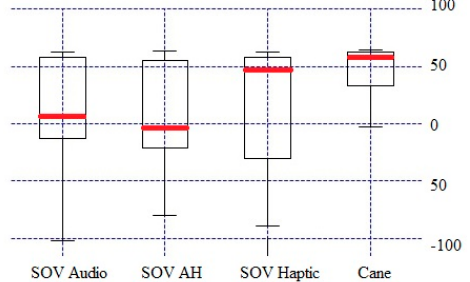
Figure 17. The total cognitive load (CL) for the TH—configuration C task.